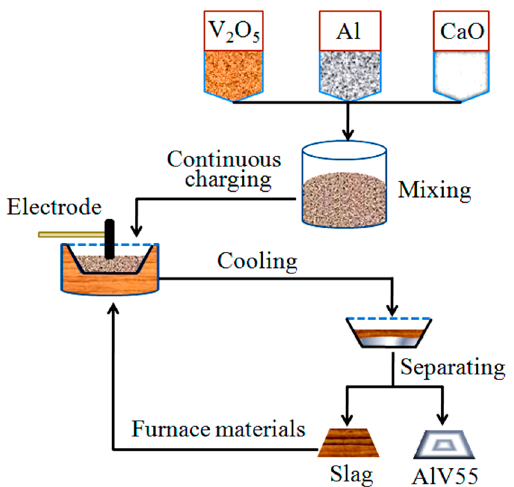
Figure 1. Schematic diagram of the experiments.